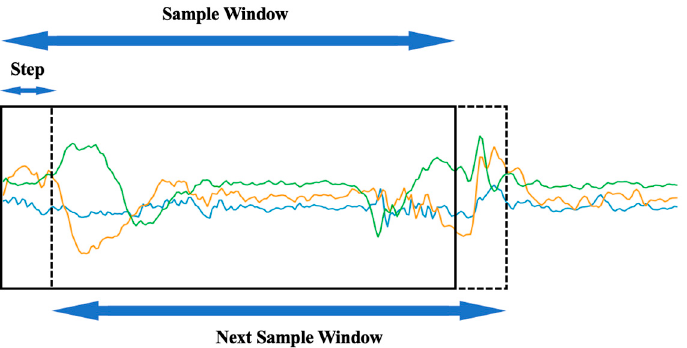
Figure 6. The detailed data augmentation procedure. The green/orange/blue lines represent the sensor data for a motion. The sample window size is 256, and the stride size of the window is 1. We received 30 identical labeled data for each 285-length motion data after data augmentation.